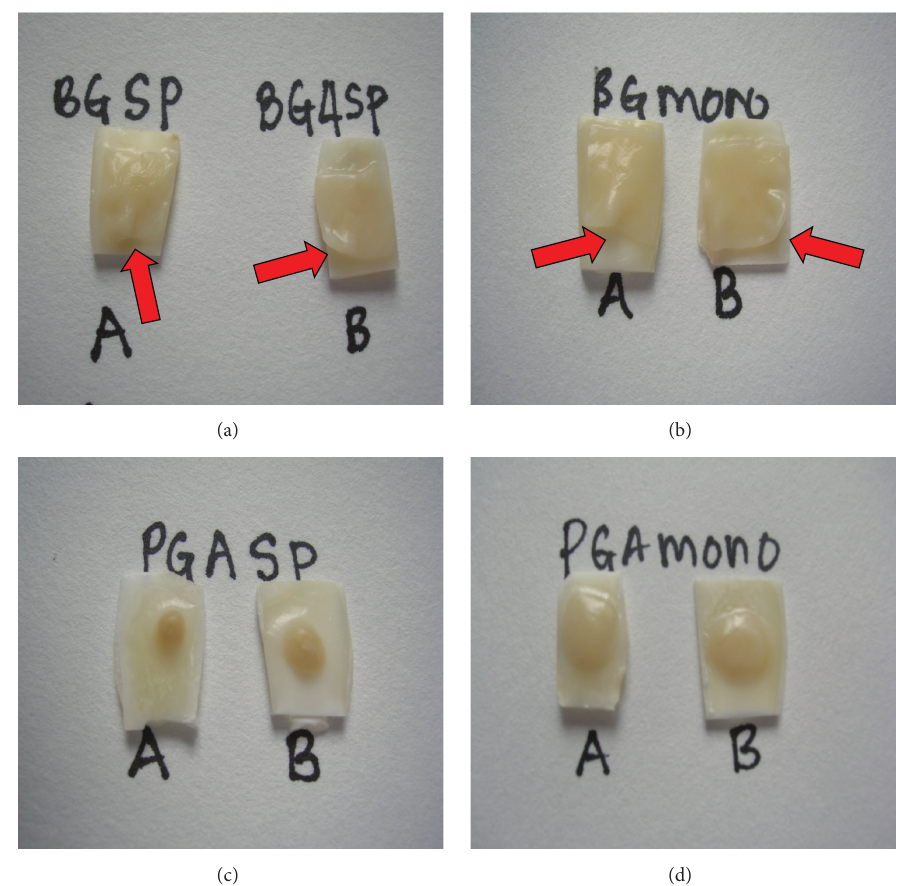
Figure 1: The appearance of PGA and collagen on dentin after 20 days in culture. (a) Spheroid-collagen, (b) monolayer seeded collagen, and (c) spheroid-PGA (d) monolayer seeded-PDLF PGA. Red arrows show the incomplete attachment of collagen on